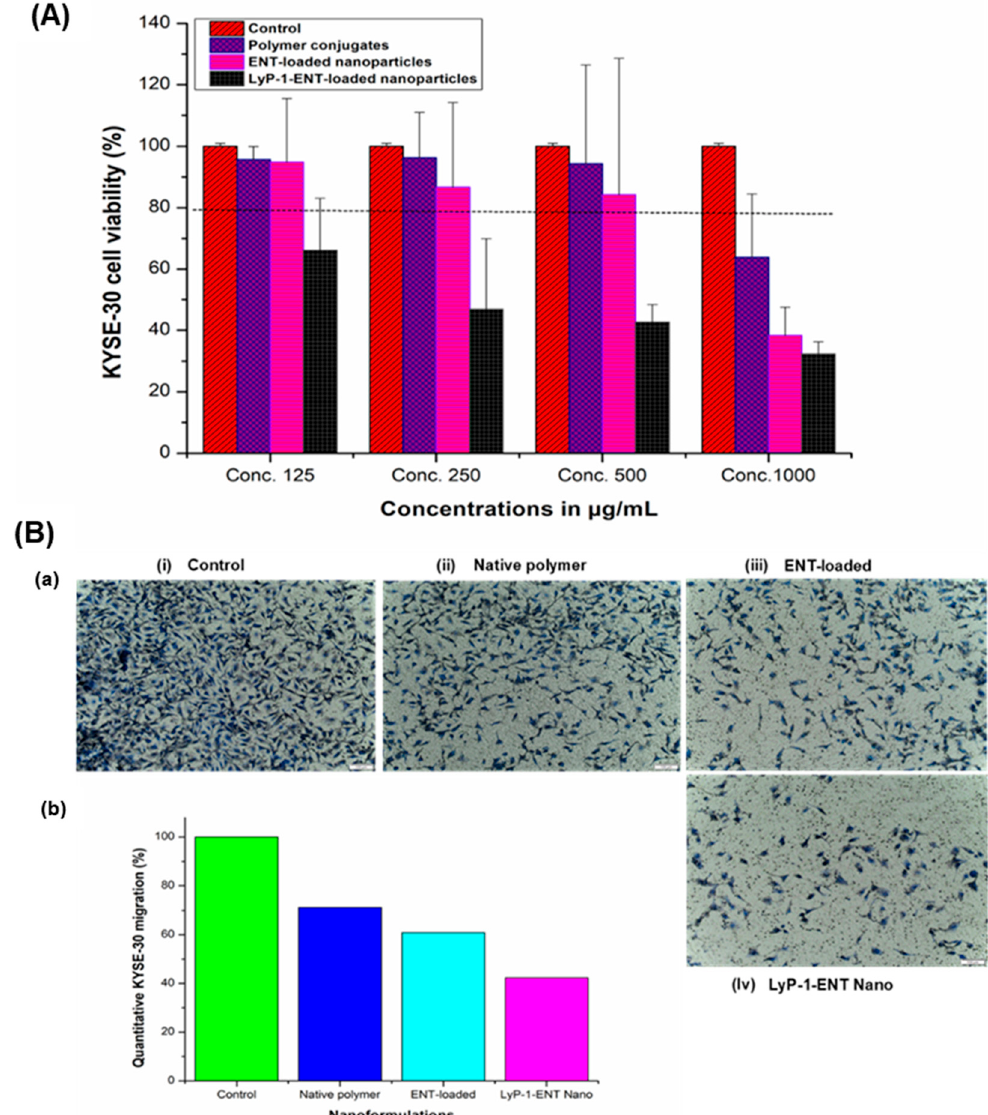
Figure 8. Cell proliferation and migration of KYSE-30 cells. ( A ) KYSE-30 cell viability after pre-incubation with nanosystems at varying concentrations for 24 h showing the proliferation effects of KYSE-30 cells. ( B ) Transwell migration assay of KYSE-30 cells pre-treated with native ENT, nanoparticles and the LyP-1-functionalized nanosystem. ( a ) Representative microscopic images of the transwell inserts of KYSE-30 cells after pre-incubation with different nanosystems: ( i ) control, ( ii ) native polymer conjugates, ( iii ) ENT-loaded nanoparticles, and ( iv ) LyP-1-functionalized ENT-loaded nanoparticles. The inserts show the macroscopic images of transwell inserts stained by trypan violet. Pores of the membranes could also be observed as the numerous small, round and dark colored dots in the picture. Images were taken at a magnification of 100 µm. ( b ) Histogram showing the quantification of the relative migration of KYSE-30 cells toward the chemo-attractant. Relative cell migration is expressed as the percentage of migrated cells with treatment compared to those without treatment (control). Results were computed from the average of triplicate samples with standard